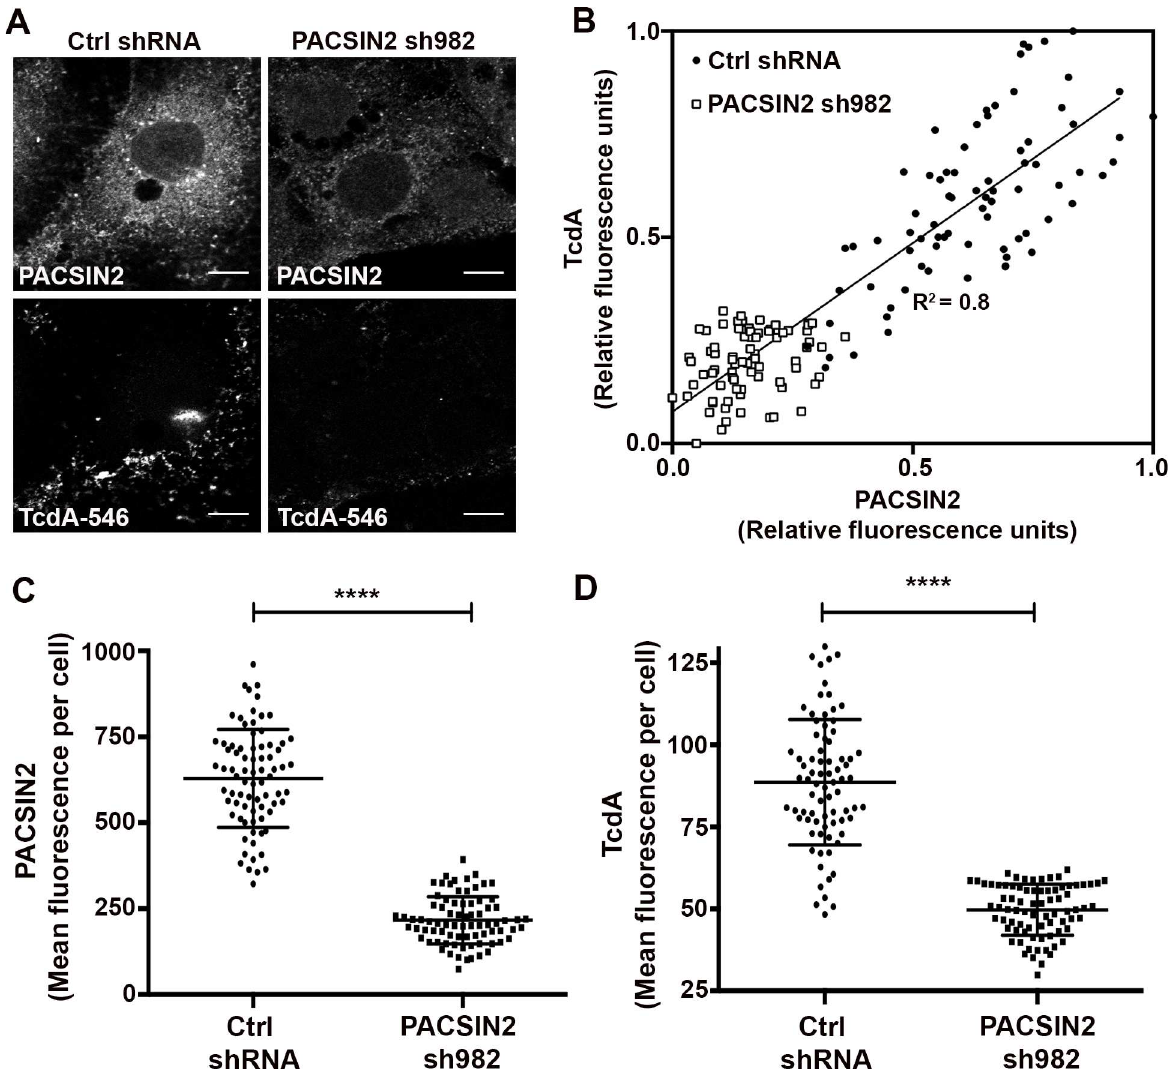
Fig 7. Depletion of PACSIN2 inhibits TcdA entry in Caco-2 cells. (A) Caco-2 cells expressingnon-targeting shRNA (Ctrl shRNA) or shRNA 982 targeting PACSIN2 were incubatedwith 50 nM TcdA-546 at 10˚C for 45 min. Unboundtoxins were removedand cells were shifted to 37˚C to allowinternalization. After 20 min, cells were washed,fixed, stainedfor PACSIN2 and imagedby confocalmicroscopy. PACSIN2 and TcdA staining from ctrl shRNA and sh982 expressingcells are shown. Scale bars, 10 μ m. The images shown are representative of multiplefields imagedfrom three independentexperiments (B) Scatter plot of the relative fluorescence intensities of PACSIN2 and TcdA in ctrl shRNA (black circles) and PACSIN2 sh982 (white squares) expressingcells. Each data point representsan individualcell. A total of 78 cells per conditionwere chosen at random for analyses. Linearregression analysiswas performed in GraphPad Prism and indicatesa strong correlationbetweenPACSIN2 and toxin levels in cells. (C) Comparisonof mean fluorescence intensities of PACSIN2 betweenctrl shRNA and PACSIN2 sh982expressingcells. Data representmean and SD of 78 individualcells. Student’st test *** p < 0.0001. (D) Comparisonof mean fluorescence intensities of TcdA betweenctrl shRNA and PACSIN2 sh982 expressingcells. Data represent mean and SEM of 78 individualcells. Student’s t test *** p <